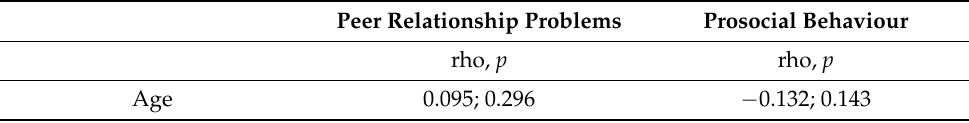
Table 2. Correlation between age and peer relationship problems and prosocial